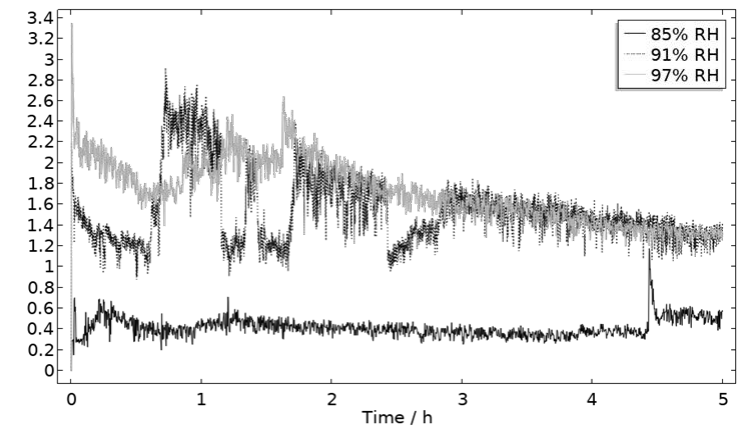
Figure 8. Monitored galvanic current during 5 h of exposure of the calibration cell with 86 μg NaCl/cm2 load at 21 °C at 85%, 91%, and 97% RH.